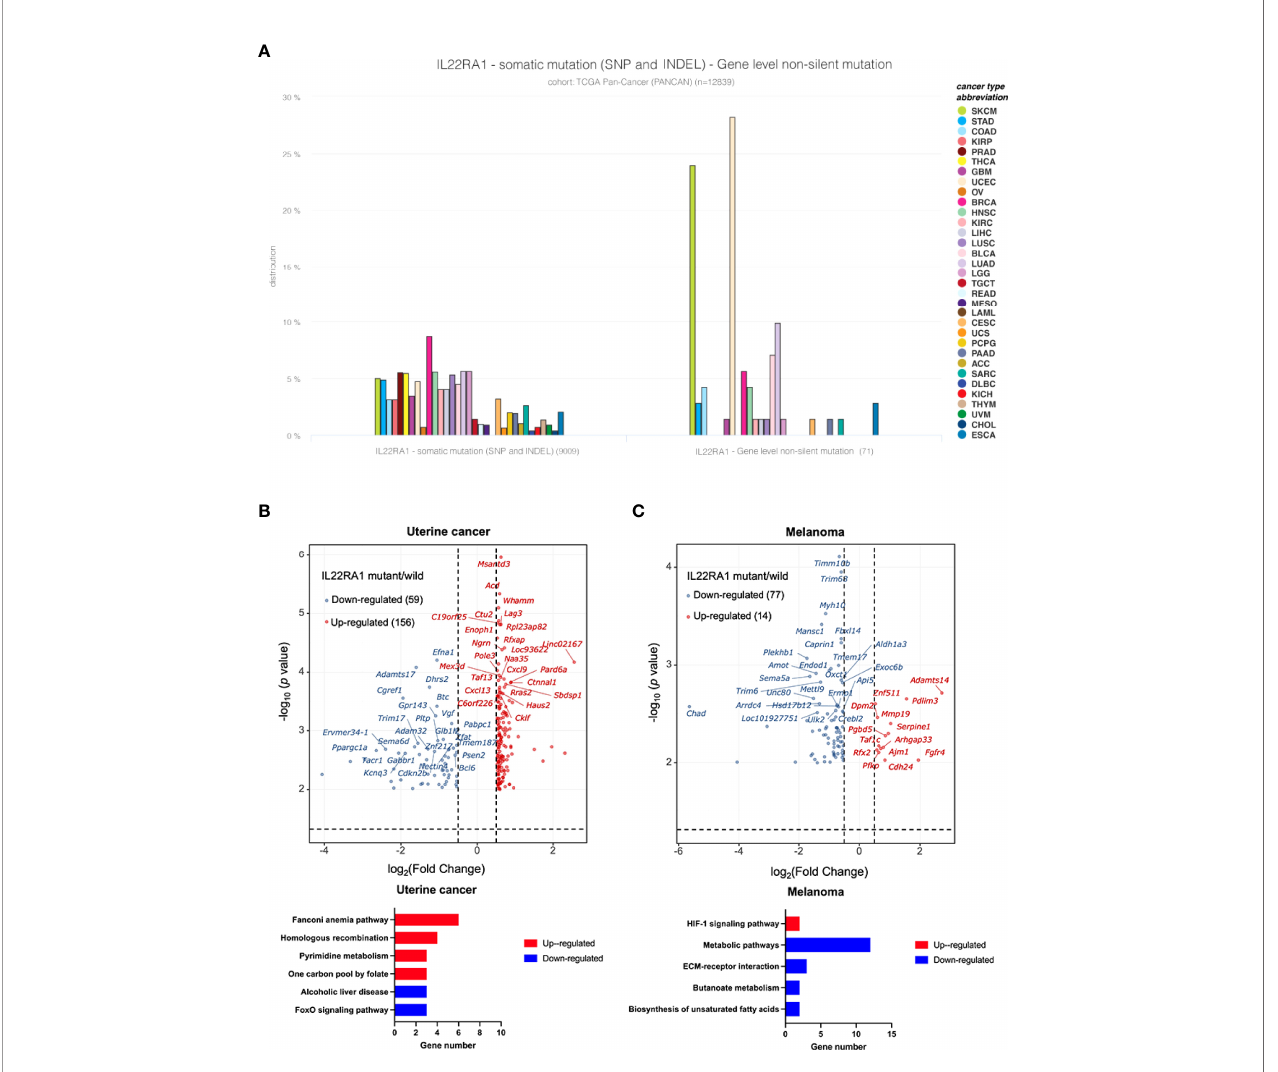
FIGURE 4 | IL22RA1 mutation affects metabolic pathways in uterine cancer and melanoma. (A) Incidence of IL22RA1 mutation in different cancer types shows both UCEC and SKCM are major cancer types with higher mutation rate. (B) Volcano plot displaying the differentially expressed genes (|fold change|>1.5 and adjusted p < 0.05) after IL22RA1 mutation in uterine cancer (upper), and KEGG pathways for the upregulated and downregulated genes. (C) Volcano plot displaying differentially expressed genes (|fold change| >1.5 and adjusted p < 0.05) after IL22RA1 mutation in melanoma (upper), and KEGG pathways for the upregulated and downregulated